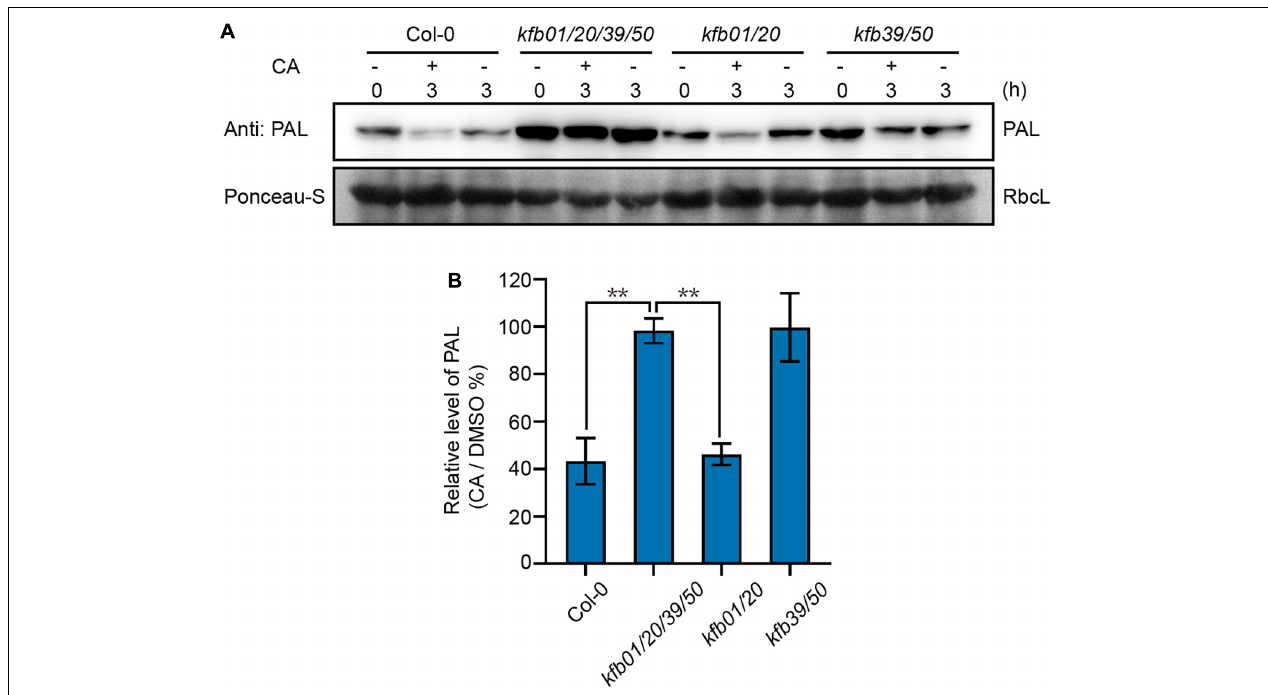
FIGURE 4 | Exogenous CA induces the degradation of PAL proteins mainly through KFB39 and KFB50. (A) The protein level of PAL in Col-0, kfb01/20/39/50 , kfb01/20, and kfb39/50 seedlings after CA treatment. Two-week-old Col-0, kfb01/20/39/50 , kfb01/20, and kfb39/50 seedlings were treated with 0.1 mM CA for 3 h and the solvent DMSO was used as control. Ponceau staining of RbcL was shown as loading control. (B) Quantitative analysis of the band intensity in (A) . Protein contents were normalized to the corresponding content of RbcL by Ponceau staining. The relative level of PAL (CA/DMSO%) at 0 min was set to 100%. Error bars are means ± SD (Student’s t -test, ** P < 0.01, n =